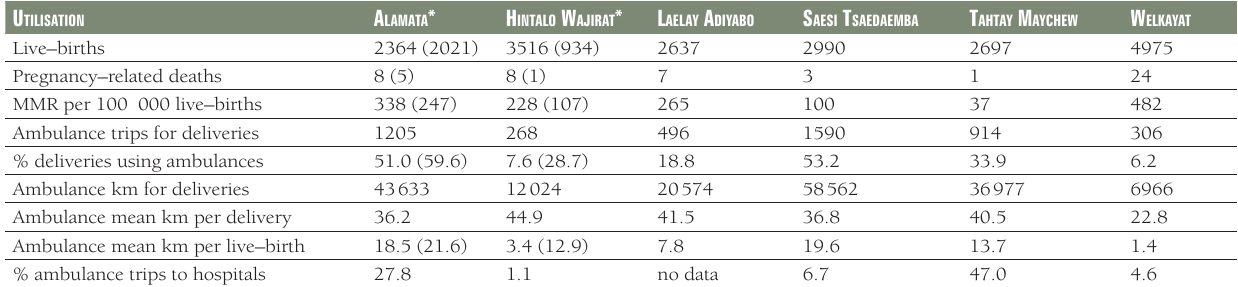
Table 1. Ambulance utilisation in relation to delivery care across six rural Districts in Tigray Region, Ethiopia, over a one–year period